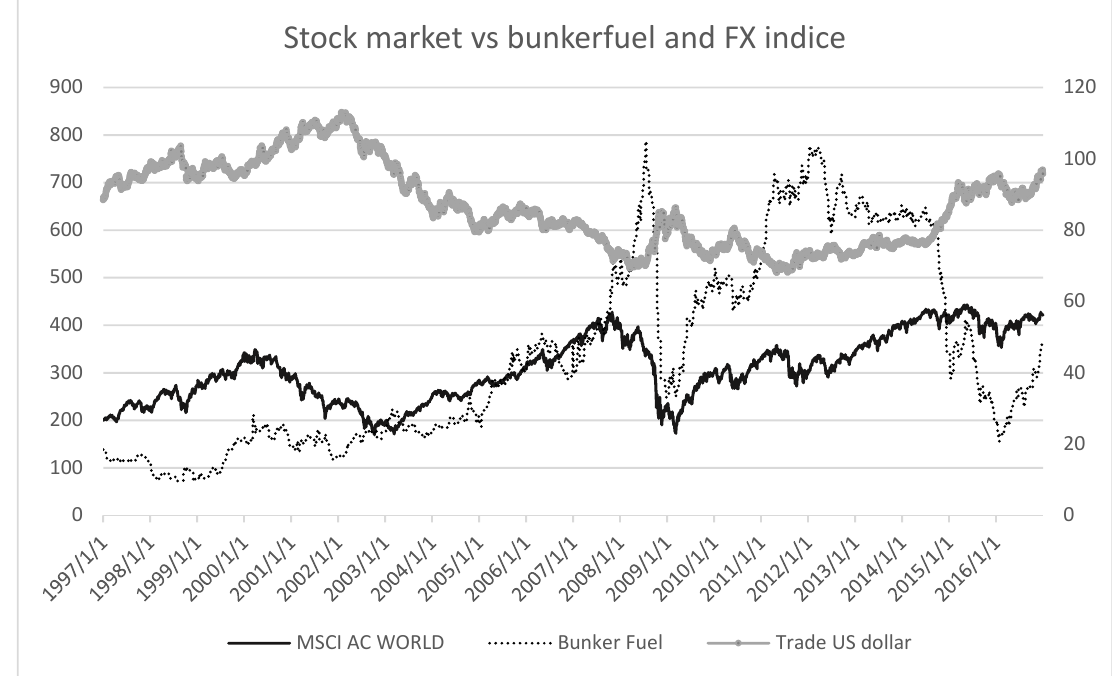
Figure 2. Stock market index versus fuel cost and USD basket index. Note: Bunker Fuel and FX (Foreign Exchange) indexes are on the right-hand side axis. Morgan Stanley Capital International (MSCI) All Country World Index (ACWI) is on the left-hand side axis.